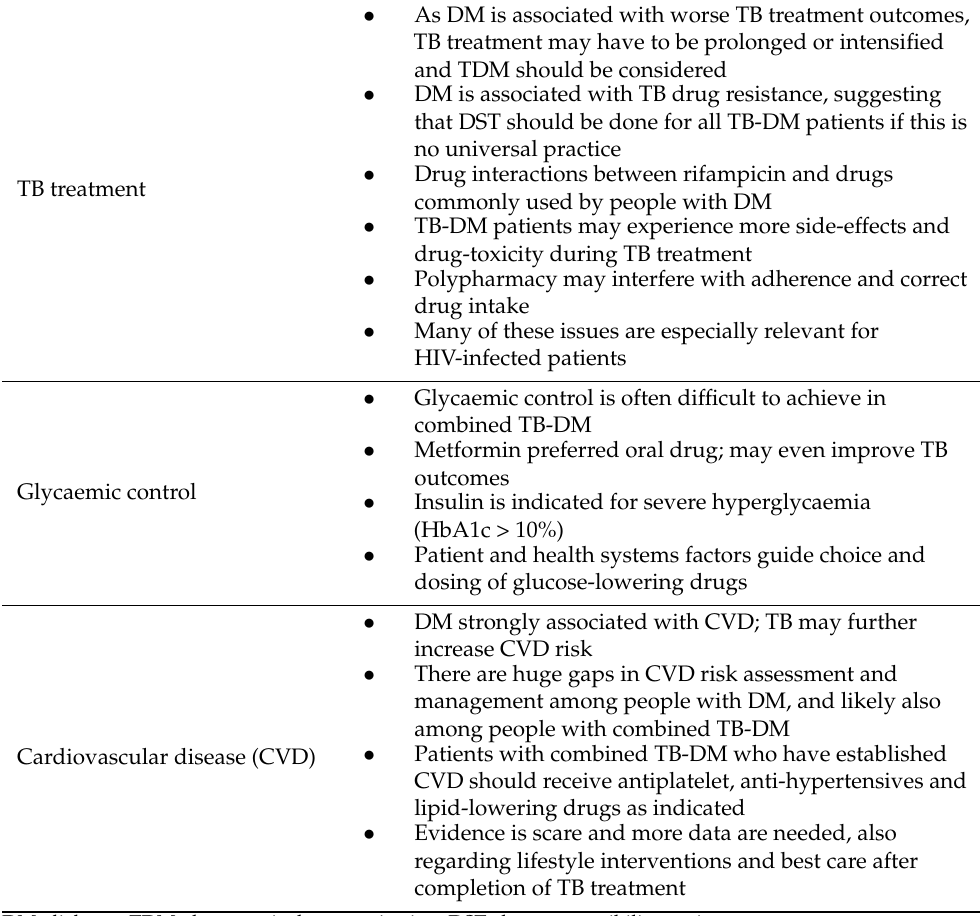
Table 2. Key Issues Related to Treatment of Combined Diabetes and